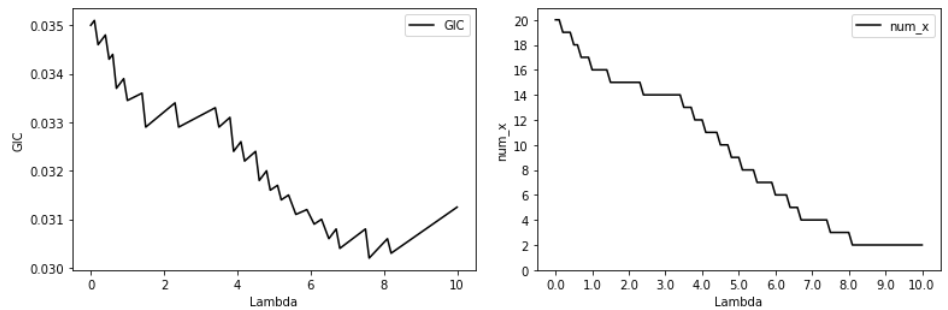
Figure 1. Plots the trend of GIC and the number of variables with